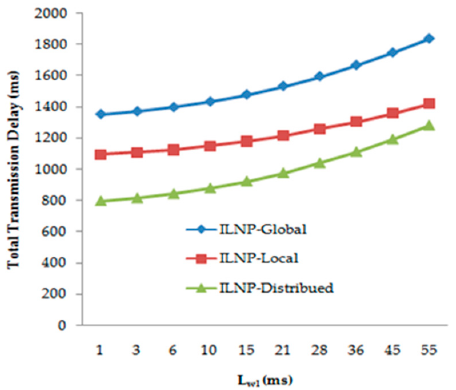
Figure 19. Impact of L wl on TTD.